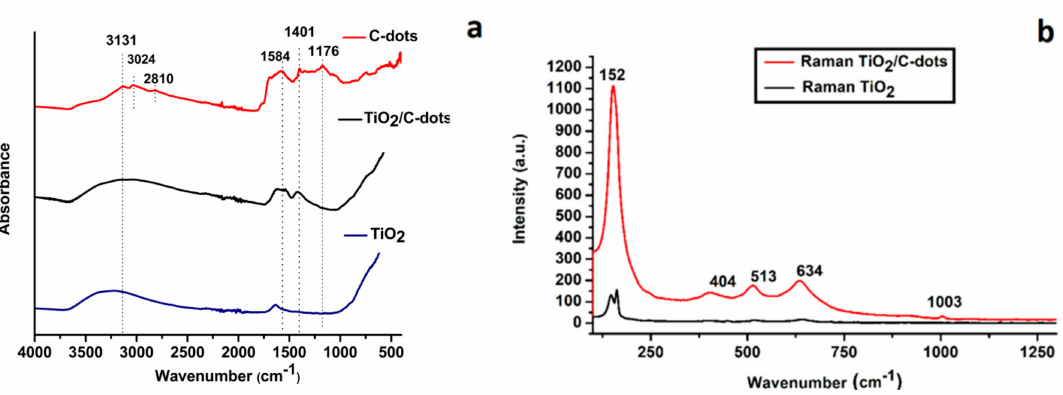
Figure 9. ( a ) FTIR spectra of C-dots, TiO 2 and TiO 2 enriched with C-dots. ( b ) Raman spectra of TiO 2 and TiO 2 enriched with C-dots.